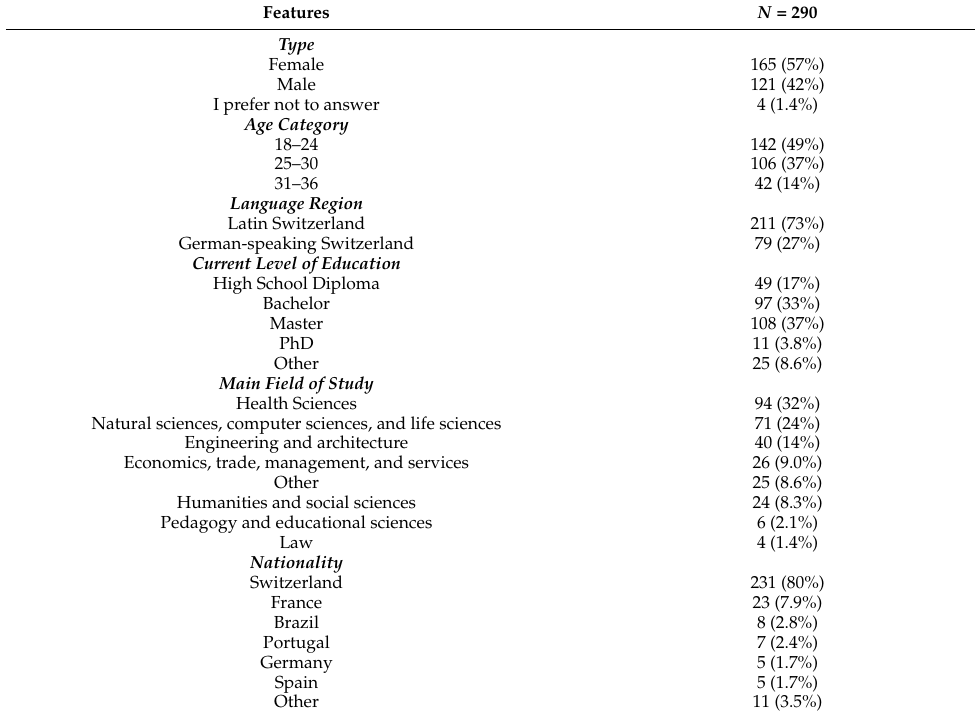
Table 1. Socio-demographic characteristics of the